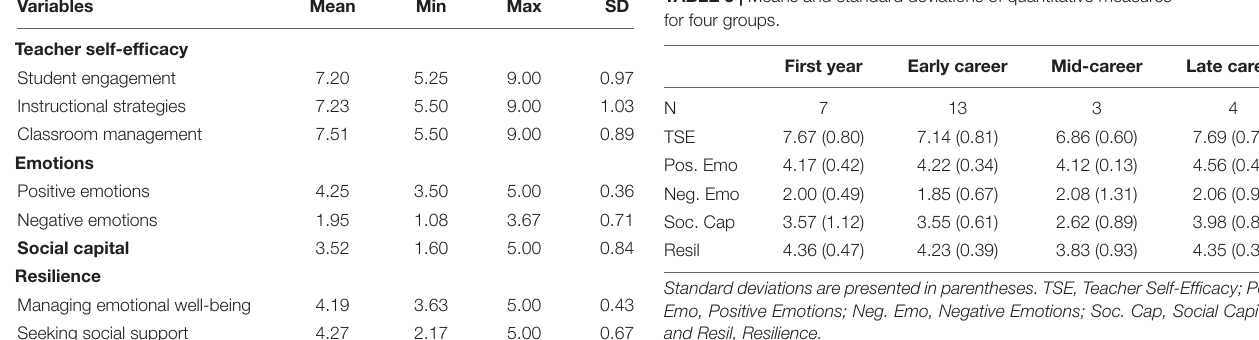
TABLE 3 | Means and standard deviations of quantitative measures for four groups.